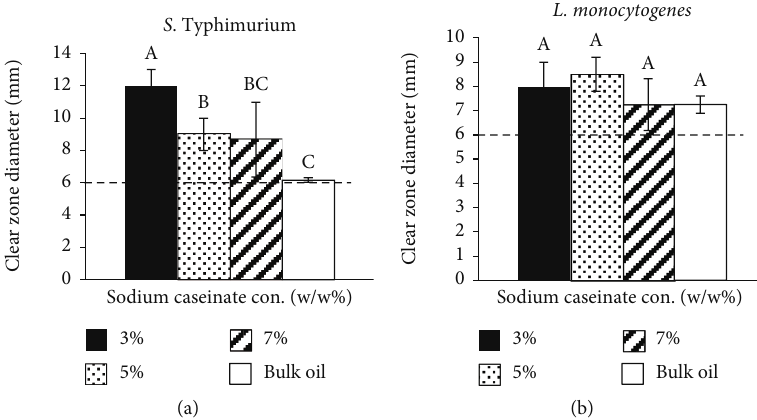
Figure 2: The e ff ect of various concentrations of sodium caseinate as an emulsi fi er on clear zone diameter (mm) of S. Typhimurium (a) and L. monocytogenes (b). Values are means ± standard deviations ( n = 3 ). Inhibition zone includes diameter of disc (6 mm). Di ff erent letters show statistically signi fi cant di ff erences between values ( p < 0 : 05 ). Table 3: The sample order based on the top to poor